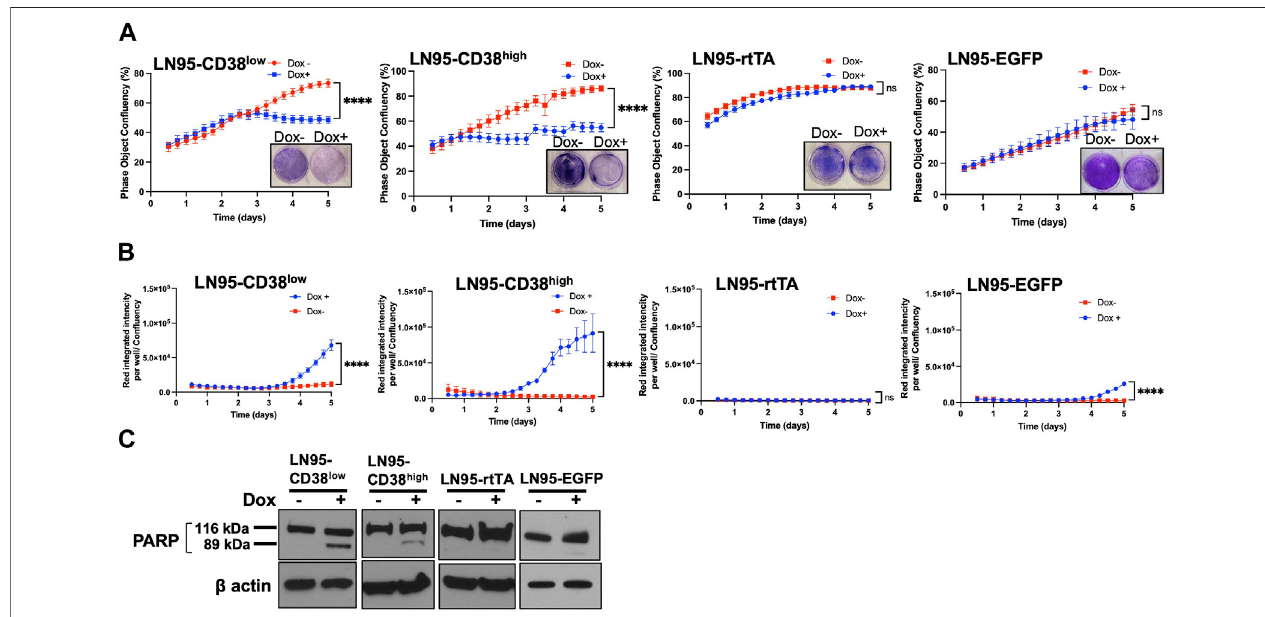
FIGURE 2 | Apoptosis induced by CD38. (A) Cell growth with or without 100 ng/ml Dox measured by IncuCyte and crystal violet staining. Con fl uency was measured by phase-contrast images every 2 hrs for 5 days. Mean ± SD values from four replicates are shown. Crystal violet staining was performed on Day 4. ns: not signi fi cant, ****: p < 0.0001. (B) Apoptosis assay by IncuCyte. Mean ± SD values from four replicates are shown. ns: not signi fi cant, ****: p < 0.0001. (C) Western blot analysis of PARP1 cleavage on Day